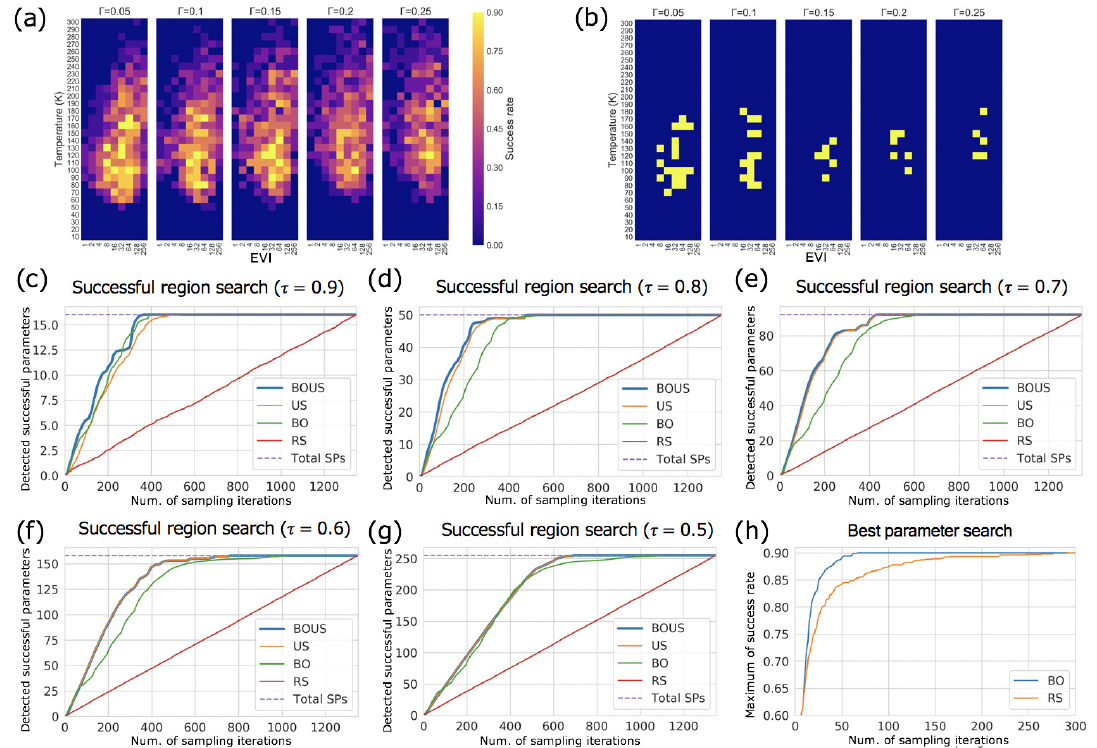
Figure 5. Results of Langevin dynamics simulations. ( a ) Success rate distribution in the parameter space. ( b ) Successful parameter region (yellow) with τ = 0.8. ( c – g ) show performances of parameter region search using BOUS, US, BO, and RS. The success thresholds are 0.9 ( c ), 0.8 ( d ), 0.7 ( e ), 0.6 ( f ), and 0.5 ( g ), respectively. ( h ) shows the performance of BO and RS for the best parameter